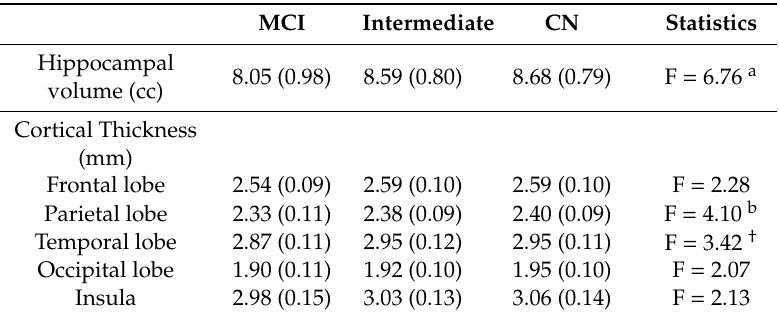
Table 4. Neuroimaging